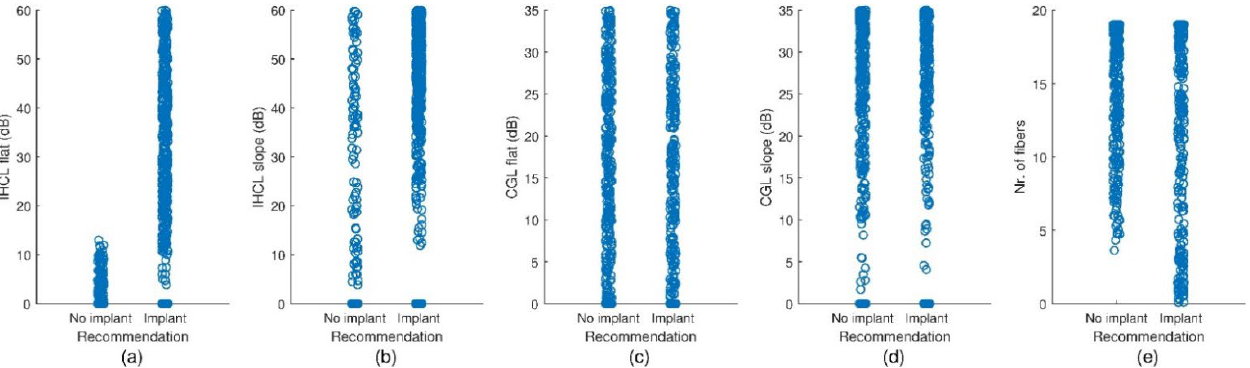
with regard to implantation and Ψ = {I f , I s , O f , O s , N fib } and ; and ( e ) the I f , reflecting cochlear synaptopathy. O f O s N fib